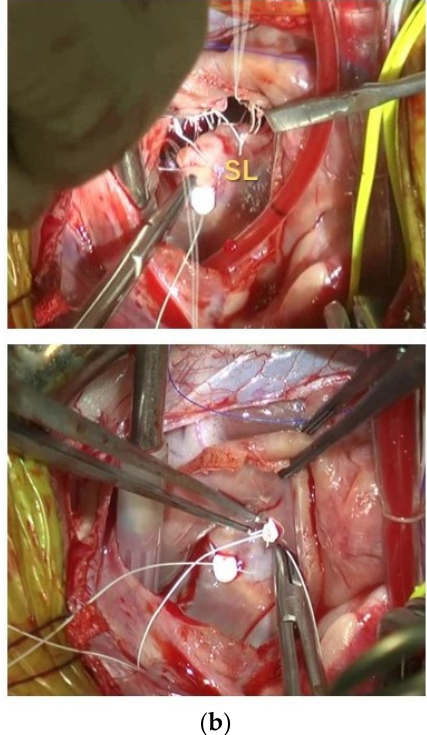
Figure 3. De Vega annuloplasty. ( a ) Schema of De Vega annuloplasty, in which the annulus is sutured down to the size of the septal leaflet. The mitral annulus, except the base of the septal leaflet, is stitched using CV-5 ePTFE sutures with a purse-string suture through pledgets. If the weight was more than 5 kg, a horizontal mattress suture was added to secure it more rigidly. ( b ) Intraoperative photos showing the septal leaflet (top). The mitral valve is visualized at the status of mitral valve coaptation by injecting cooled saline solution into the left ventricle to confirm the size of the septal leaflet or the presence of MR (bottom). SL: Septal leaflet; ML: mural leaflet. After MODEL surgery, the left atrium was closed with double continuous sutures, Statistical analysis was performed using statistical analysis software (BellCurve for Excel, Social Survey Research Information Co., Ltd., Tokyo, Japan). The values are presented as mean ± standard deviation when the Shapiro-Wilk test showed a normal